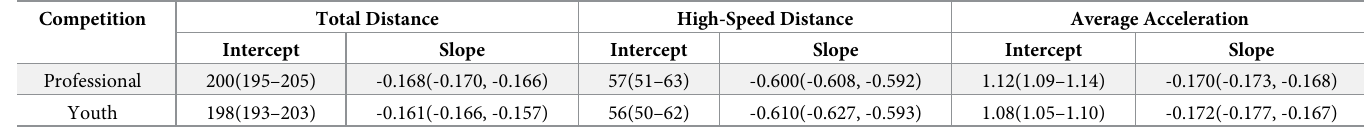
Table 2. Non-linear relationships of power law models by level of competition. Data are presented as means, with the 90% CI presented in brackets.